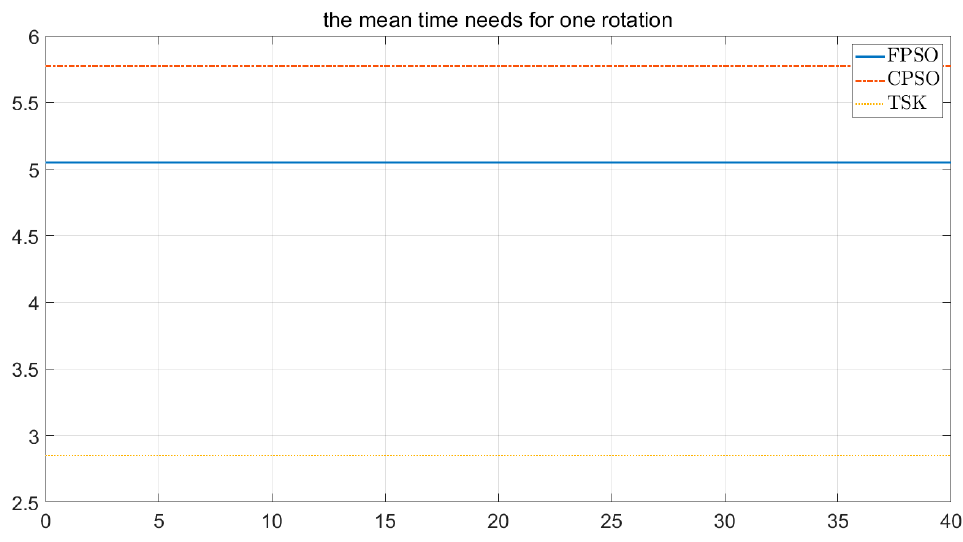
Figure 20. The mean time for one rotation in FPSO, CPSO, and fuzzy TSK.